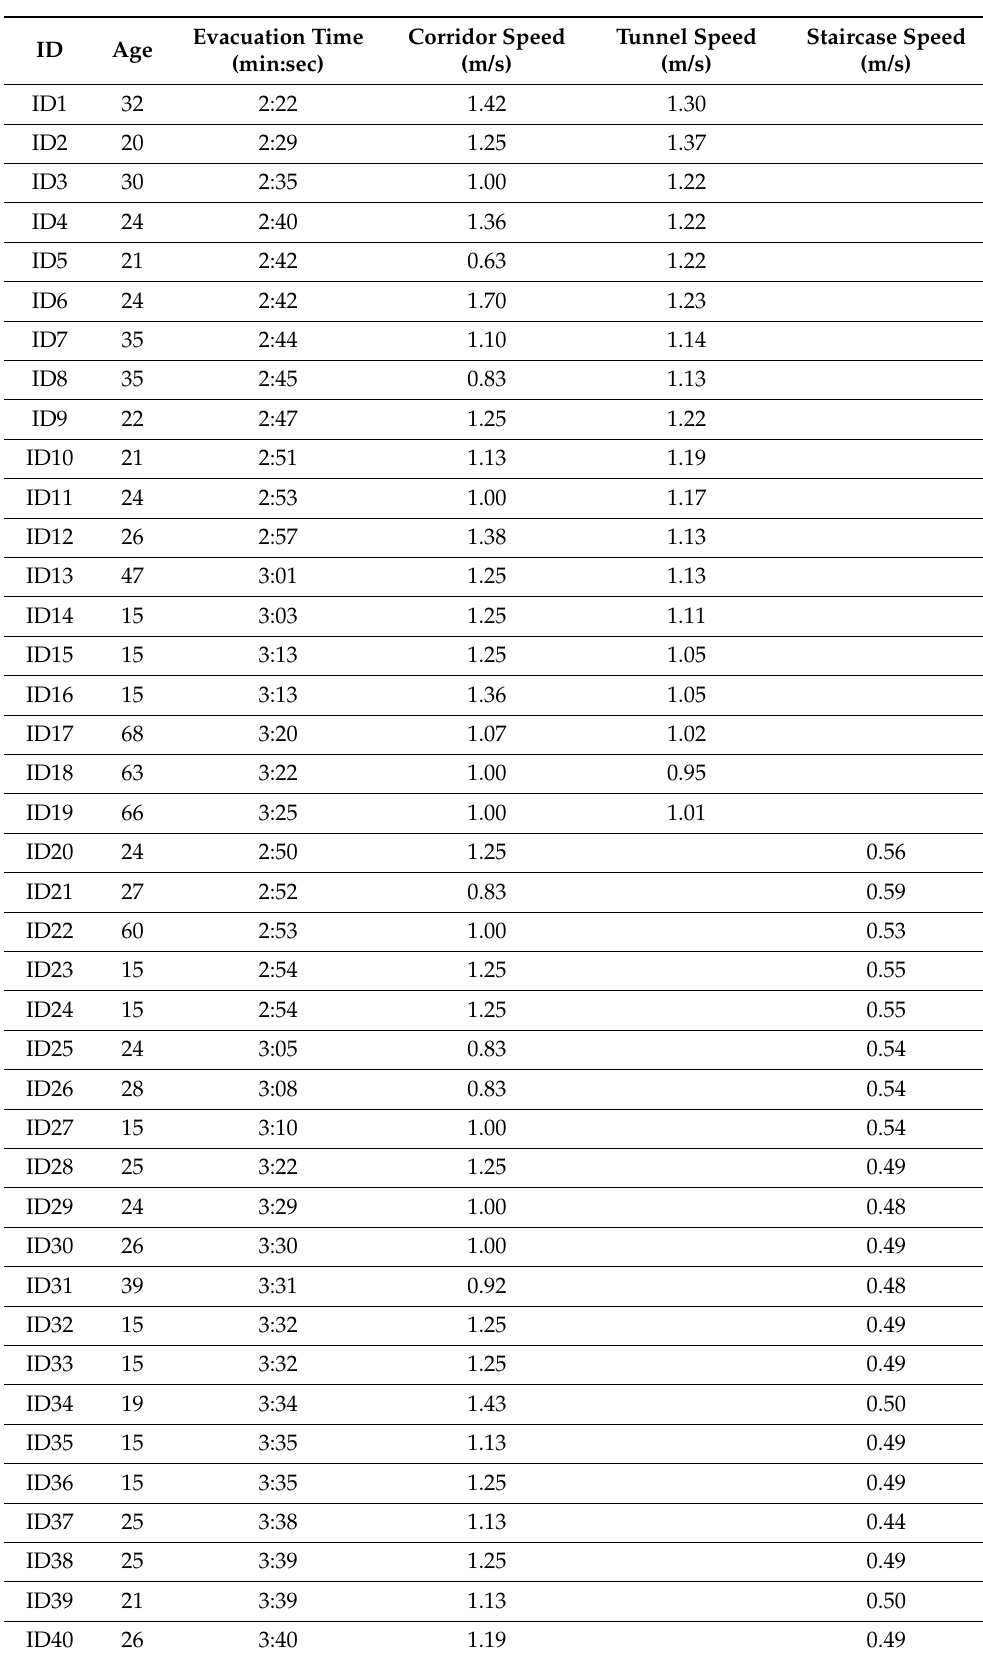
Table A1. First drill results (clear